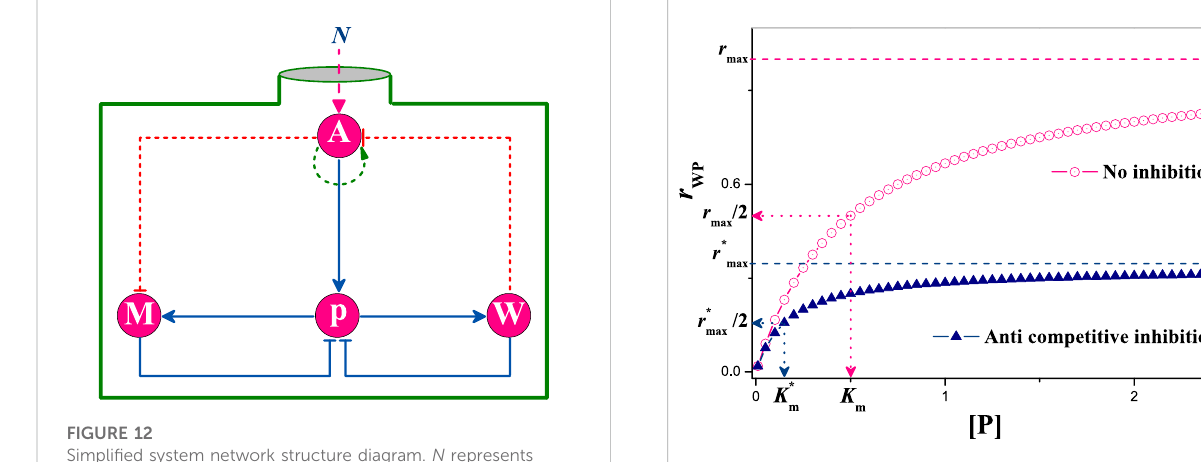
FIGURE 12 Simpli fi ed system network structure diagram. N represents the DNA damage number. FIGURE 13